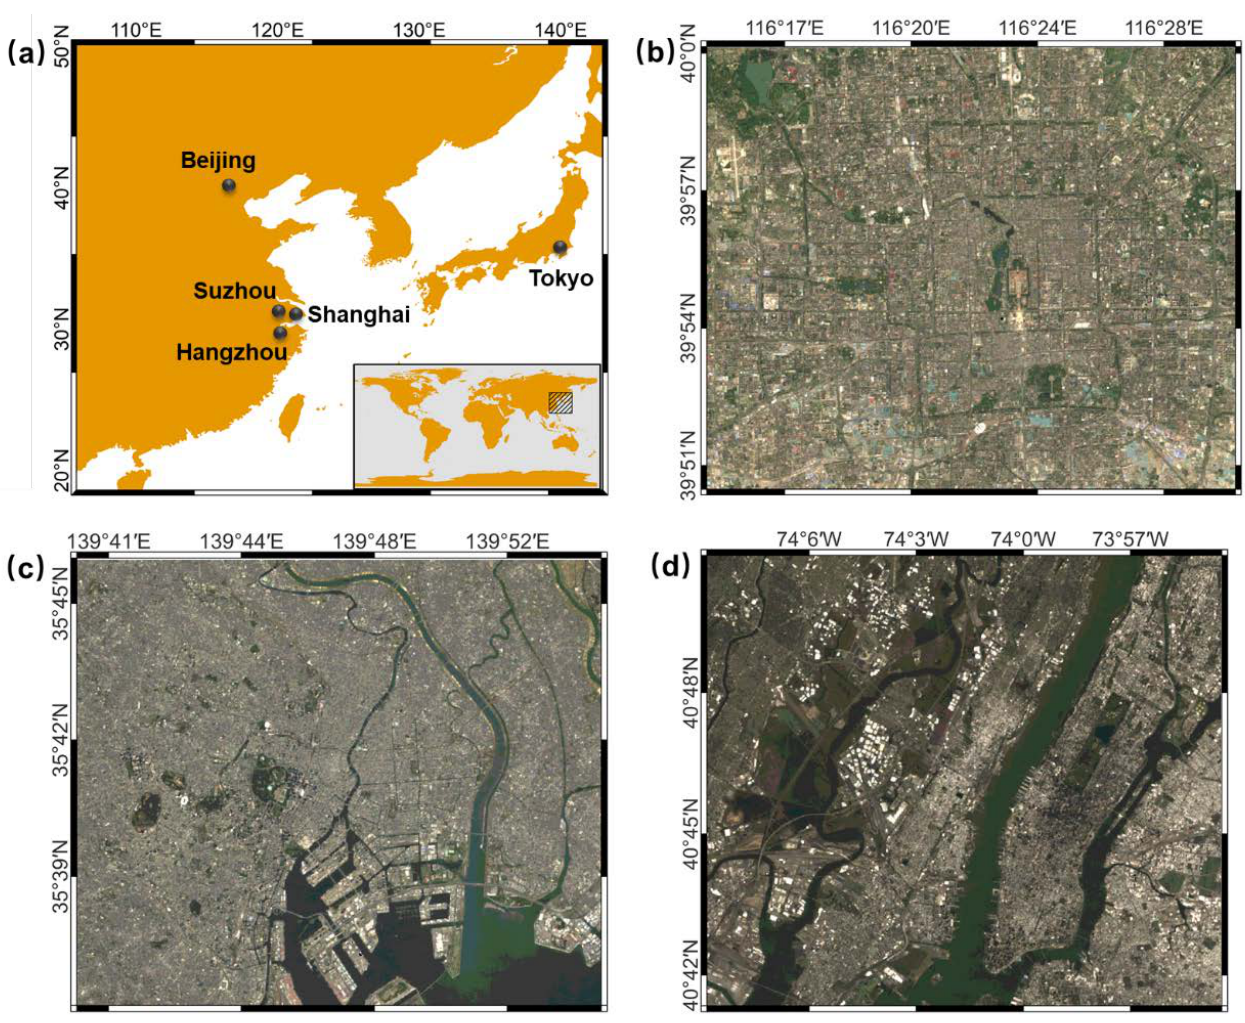
Figure 1. Subplot ( a ) is the location of the five sampling cities: Beijing, Shanghai, Hangzhou, Suzhou, and Tokyo. Subplots ( b – d ) are true color images of three validation scenes in Beijing, Tokyo, and New York, respectively.